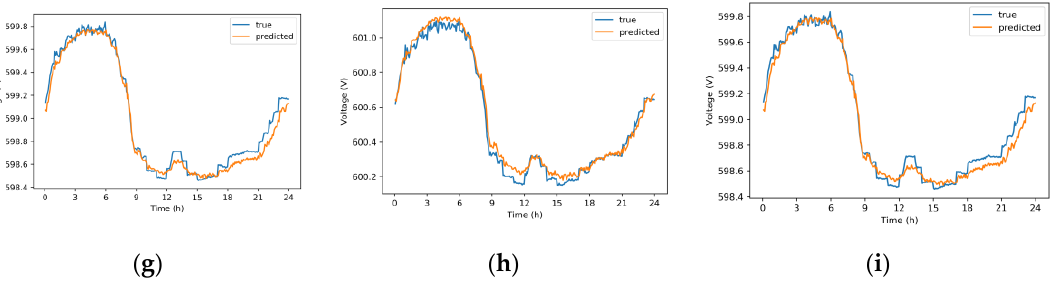
Figure 6. Modified LSTM-based voltage estimation results for: ( a ) bus 1; ( b ) bus 2; ( c ) bus 3; ( d ) bus 4; ( e ) bus 5; ( f ) bus 6; ( g ) bus 7; ( h ) bus 8; ( i ) bus 9.